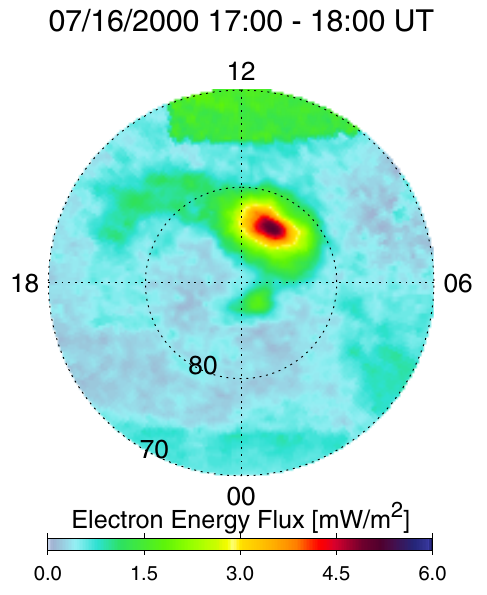
Fig. 9. The global distribution of the precipitating electron energy flux on 16 July 2000, from 17:00 UT to 18:00 UT in AACGM MLT- MLAT